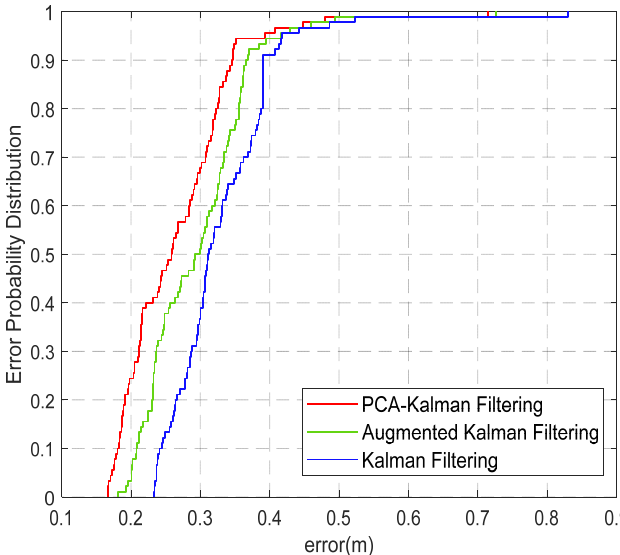
Figure 18. Error probability distribution.